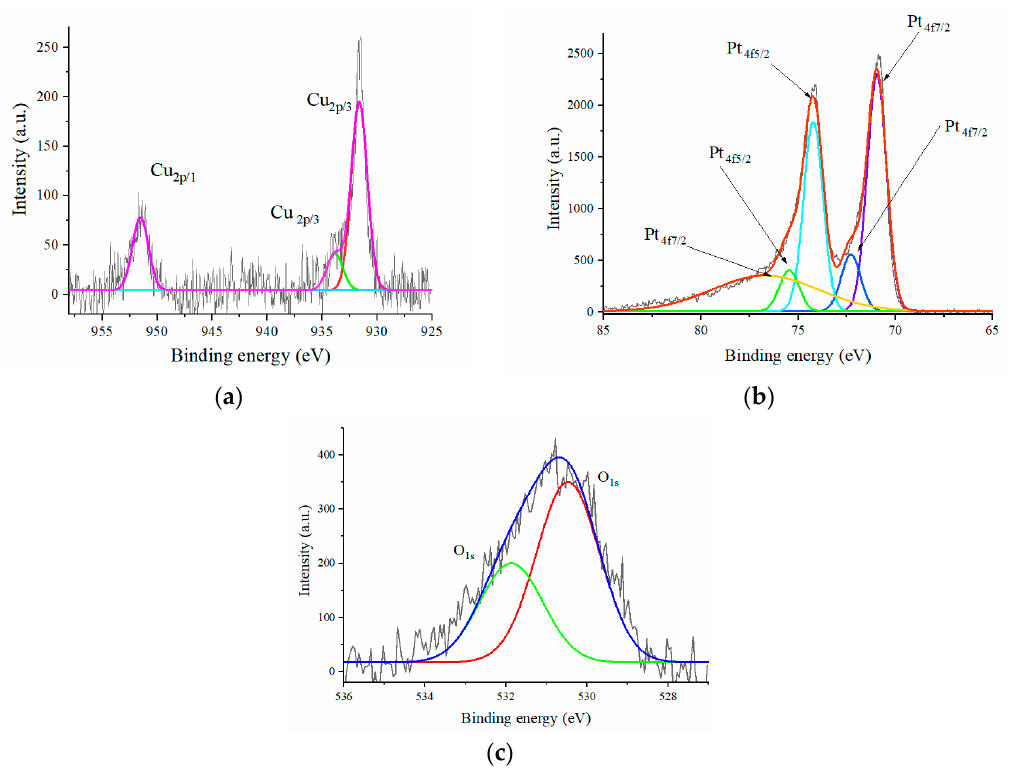
Figure 4. XPS spectra of the mixed Pt/Cu catalyst: ( a ) Cu spectrum, ( b ) Pt spectrum, ( c ) O spectrum.